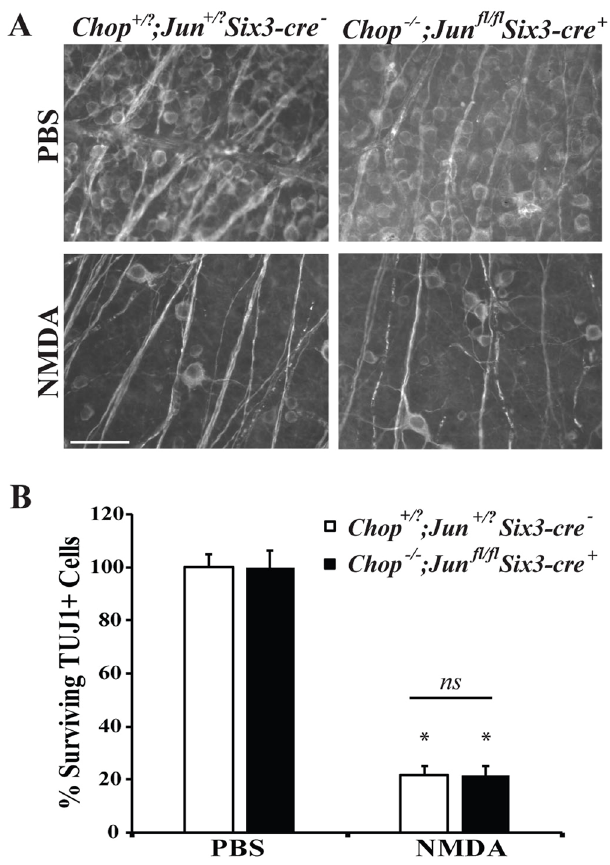
Figure 9. Combined Jun and Ddit3 deficiency does not attenuate loss of RGCs after NMDA insult. ( A ) Representative images showing TUJ1 immunolabeled cells in the GCL of Jun and Ddit3 deficient ( Jun fl/fl Ddit3 − / − ; Six3-cre + ) mice 7 days after intravitreal NMDA or PBS injection. Significant RGC loss occurred in wildtype ( Jun + /? Ddit3 + /? ; Six3-cre − ) as well as Jun and Ddit3 deficient mice after NMDA insult (n = 3 for PBS WT, n = 3 for NMDA WT, n = 4 for PBS Jun + /? Ddit3 + /? ; Six3-cre − , n = 5 for NMDA Jun + /? Ddit3 + /? ; Six3- cre − ). (B) Quantification of TUJ1 + RGCs confirmed that Jun and Ddit3 deficient mice had a similar loss of RGCs compared to wildtype mice 7d after NMDA injection ( * p < 0.001 comparing PBS to NMDA; p = 0.8582 between WT and Jun fl/fl Ddit3 − / − ; Six3-cre + NMDA, ns between genotypes). Scale bar: 50 μ